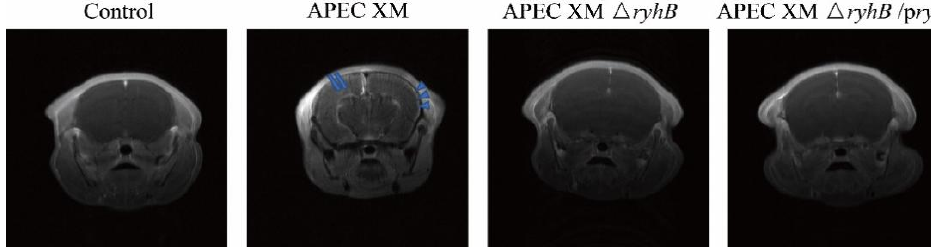
Figure 8. Lesions of mouse brains examined with MRI scanning. Abnormal contrast continuous linear enhancement of the pia mater (blue arrow) and diffusion enhancement of the cerebral parenchyma (blue arrowhead) are shown in the mouse infected with APEC XM.